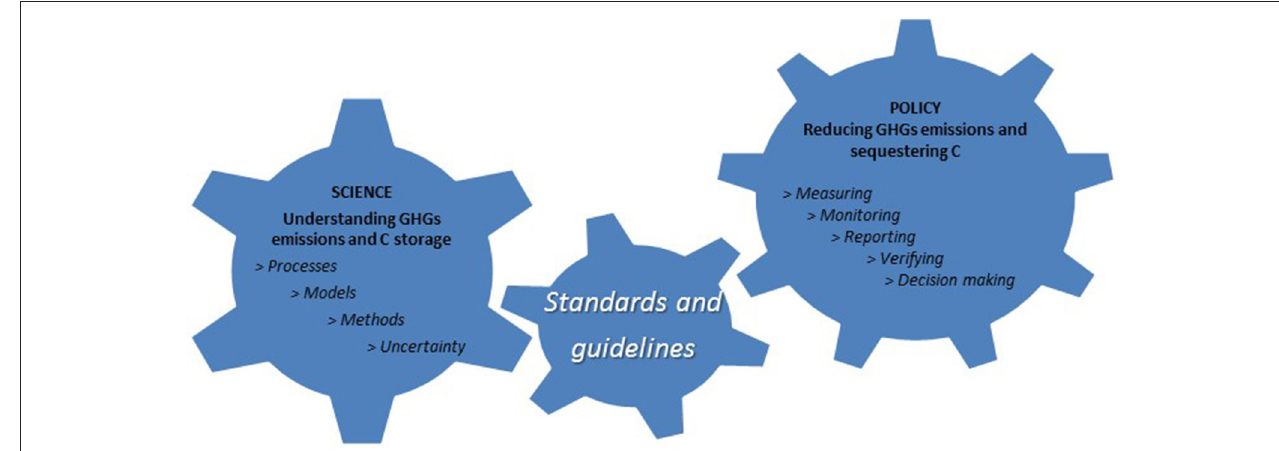
FIGURE 3 | Standards as a link between science and